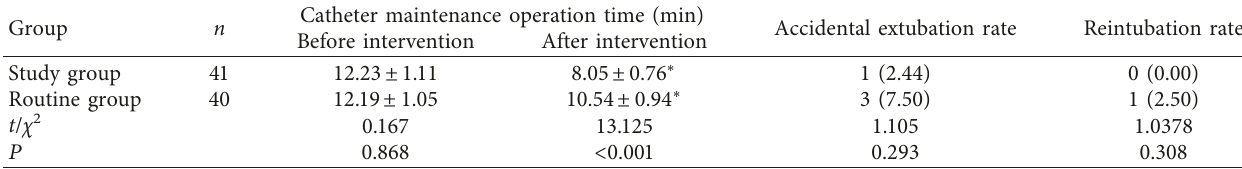
Table 1: Catheter maintenance-related indicators of the two groups [ x ± s ; n (%)].